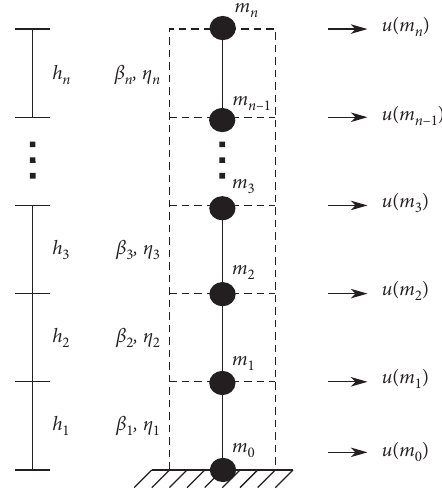
Figure 1: Discrete shear